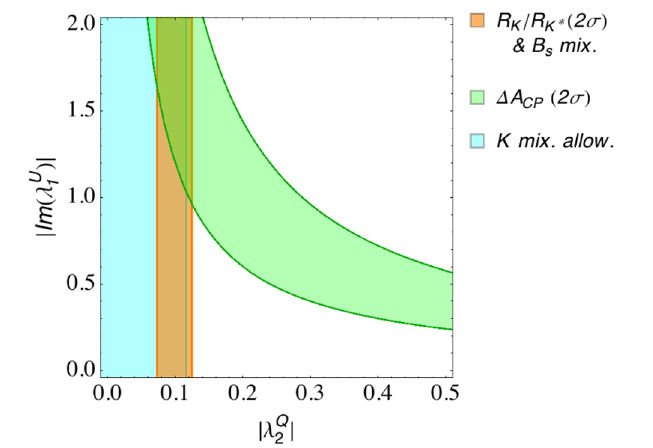
Figure 5 . Regions favoured by (cid:1) A CP (green), b ! s‘‘ (red), and allowed by B s - B s (yellow) and K - K (cyan) on the